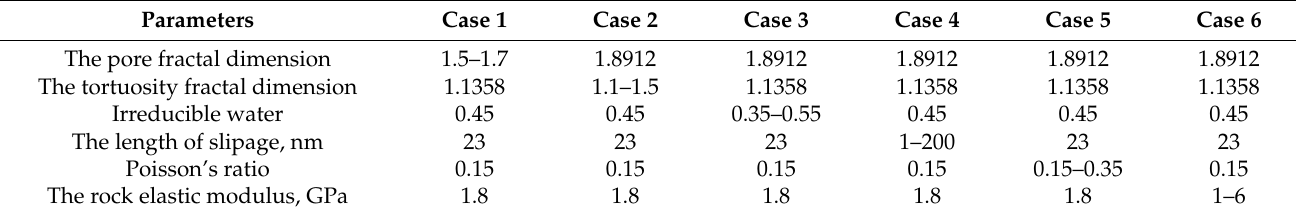
Table 5. The parameters used in case